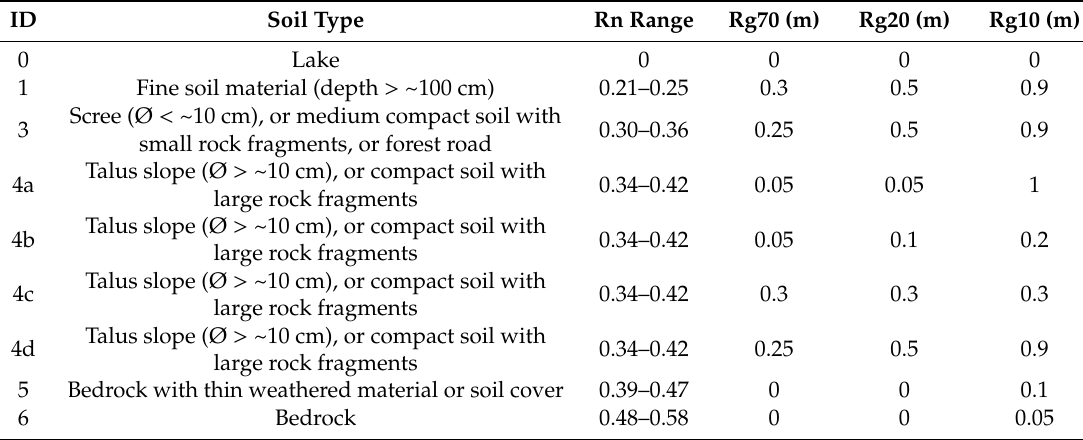
Table 5. Soil types and MOH values.